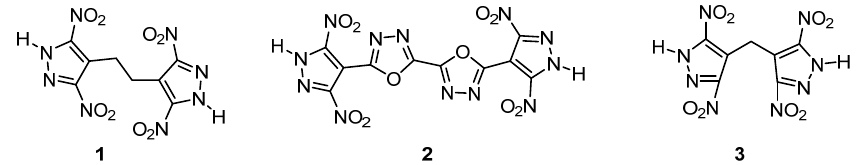
Figure 16. The structural formula for 1, 2 and 3. Adapted from ref.